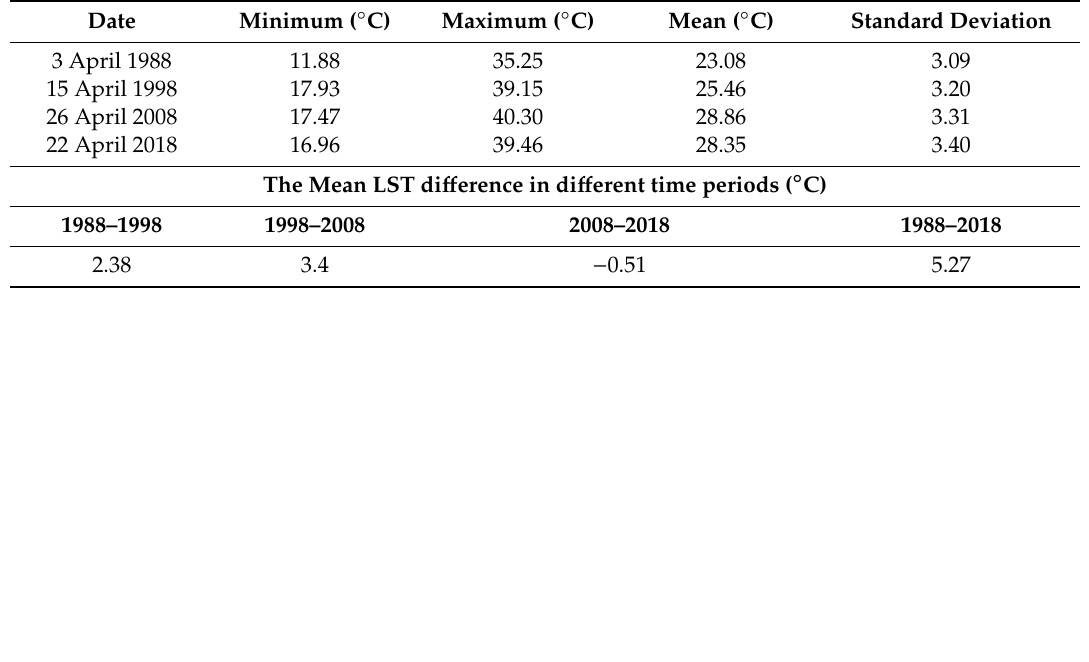
Figure 3. Information on LULC statistics of Kathmandu from 1988 to 2018 at decadal intervals (area in %).